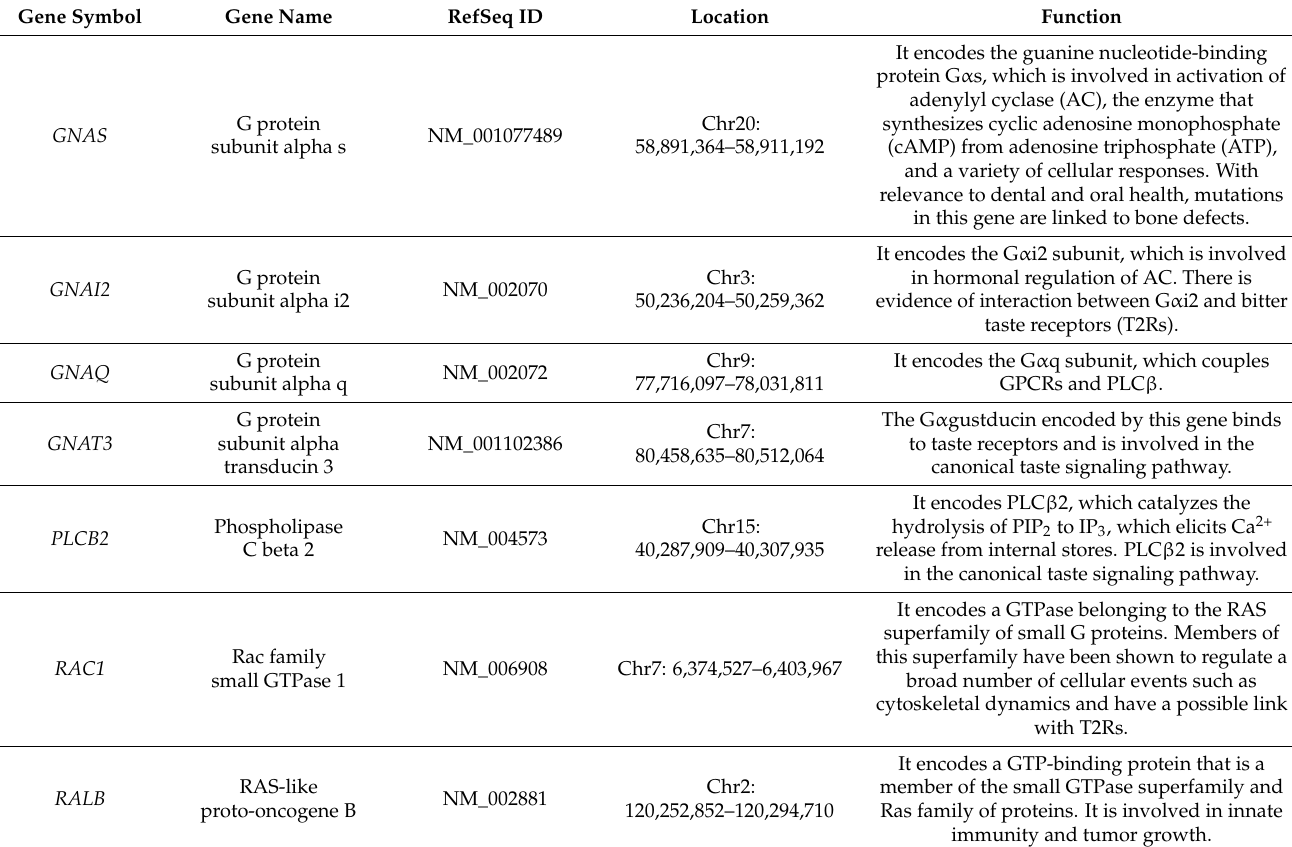
Table 3. List of sequenced